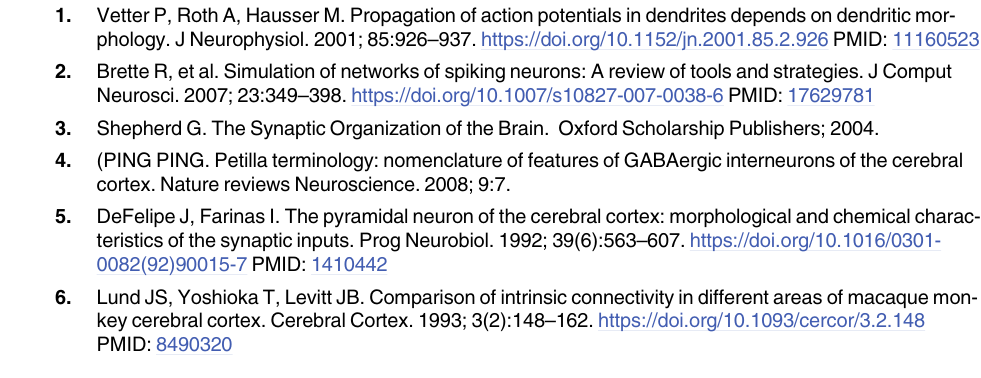
(b). The dendrogram can be read as follows: the angles between pairwise energy vectors associ- ated to red nodes are small as is for the blue nodes. However, the angles between energy vec- tors of blue and red nodes are much larger. Fig C: Detection rate method. Method used to determine detection rate. Each circle is the boundary of a disk in the Euclidean metric. Fig D: Representation of isomorphic trees. Representative isomorphic trees with entirely different (a) branching pattern and (b) tortuosity. Fig E: Representative trees in the Hausdorff metric. Rep- resentative tree (a) and similar trees (b) and (c) that are close to tree (a) in the Hausdorff met- ric. Fig F: Instability. Instability behavior for tortuosity descriptor.